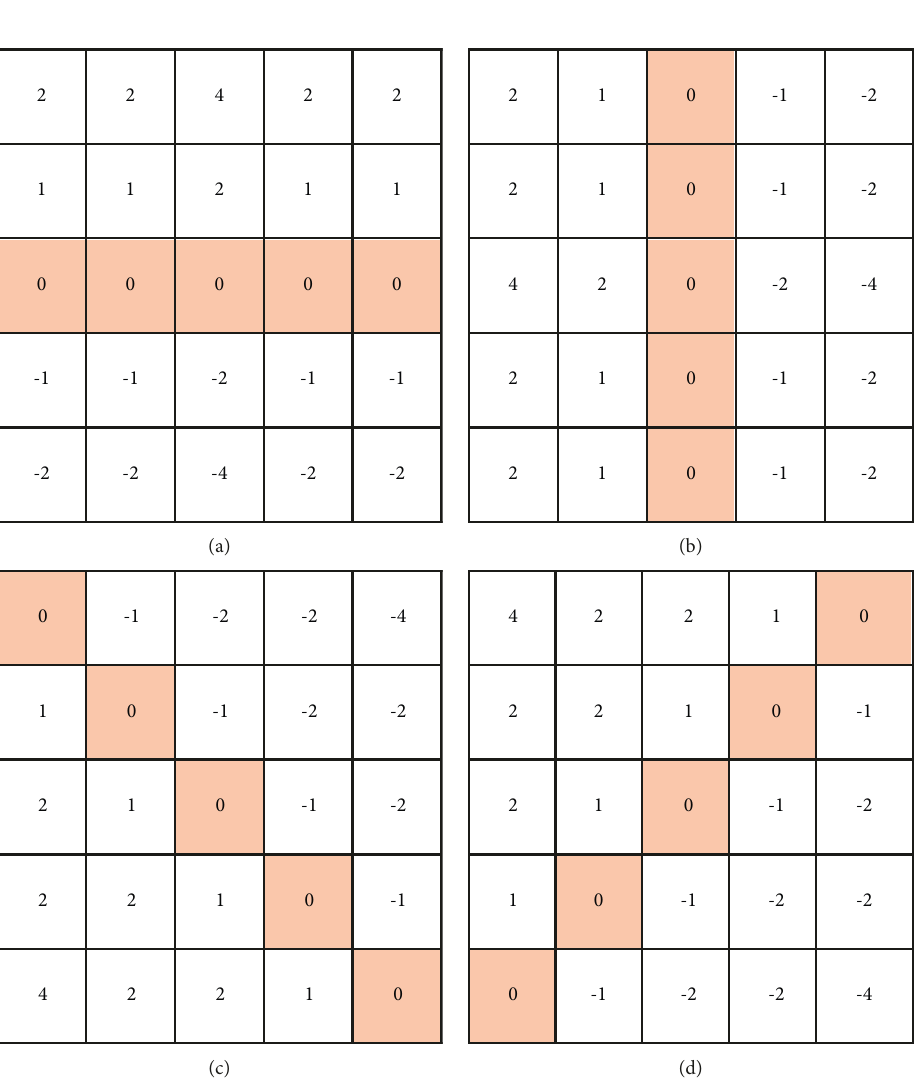
Figure 5: Edge detection kernels.